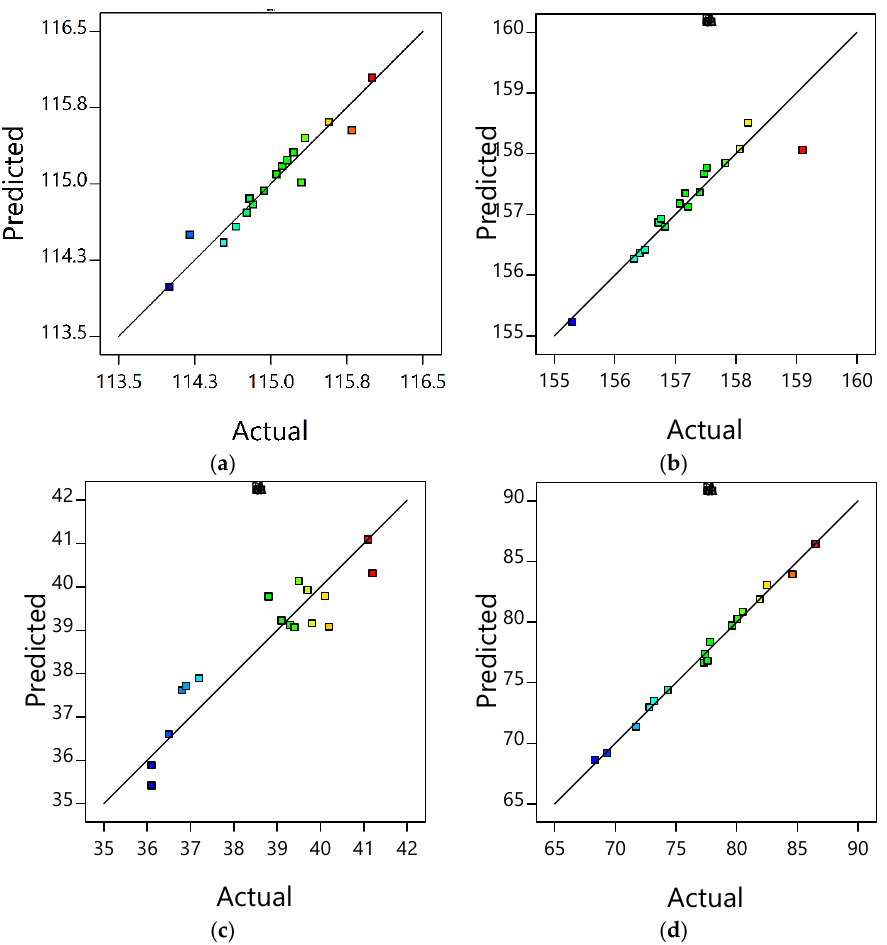
Figure 2. Plots of predicted versus actual values for: ( a ) crystallization temperature ( T C ), ( b ) first melting temperature ( T M1 ), ( c ) melt flow rate (MFR) and ( d ) heat fusion ( Hf ).